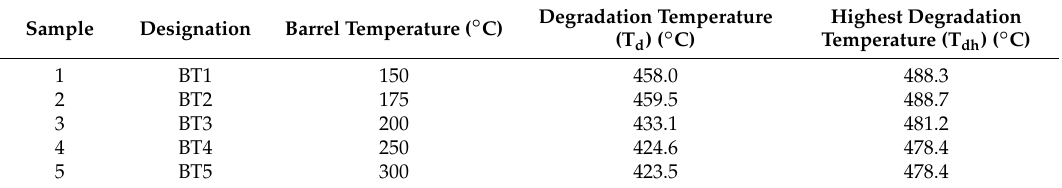
Table 3. Summary of thermogravimetric analysis (TGA) results showing the effect of barrel temperature on the degradation and the highest rate degradation temperatures of the fabricated nanocomposites.